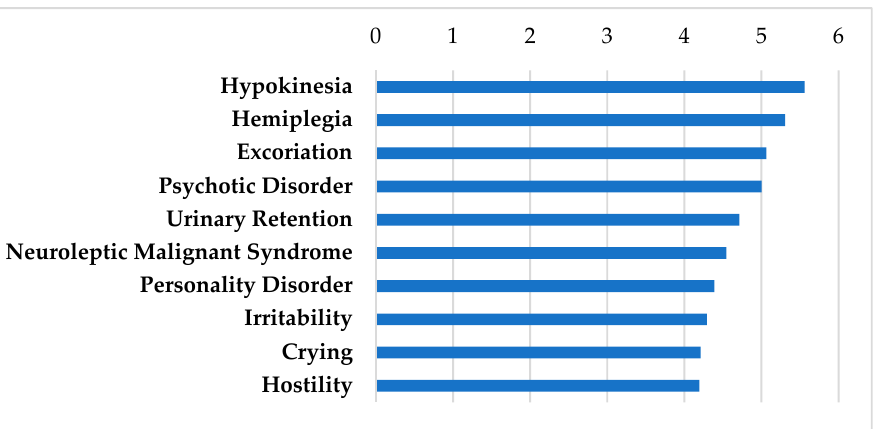
Figure 3. SIDER Side Effect Profile of drugs that work in the central nervous system. These drugs include donepezil, gabapentin, memantine, phenytoin, amantadine, and atomoxetine. Frequencies of the top 10 side effects shown are displayed according to the negative logarithm of their respective p values.